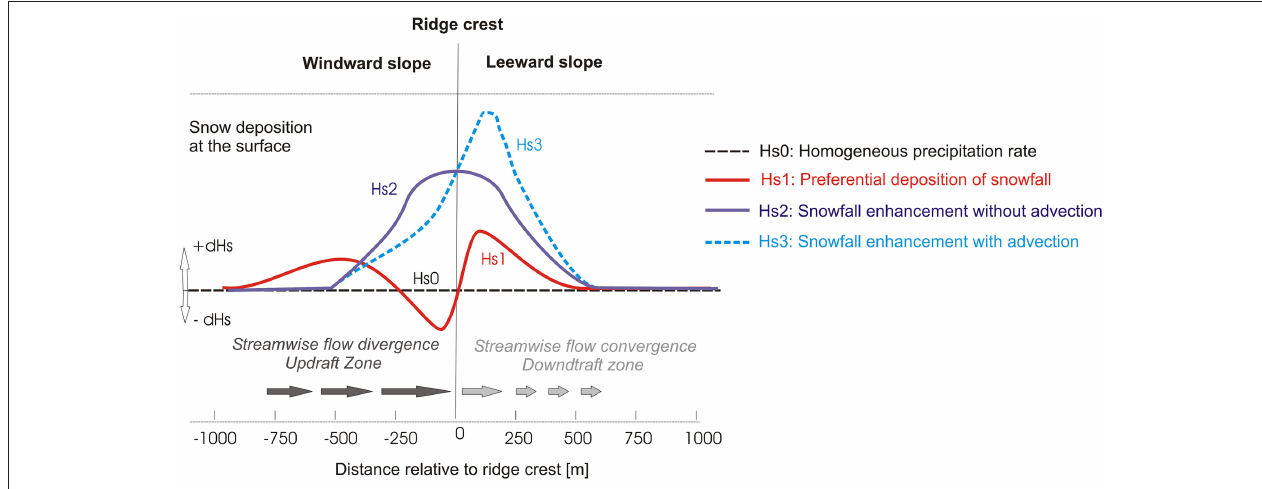
FIGURE 3 | Schematic description of final snow deposition around a ridge crest driven by homogenous precipitation rate (Hs0), preferential deposition of snowfall (Hs1), snowfall enhancement without advection by the mean wind (seeder-feeder mechanism only) (Hs2) and the combined effect of snowfall enhancement and preferential deposition of snowfall (Hs3) (Modified after Mott et al.,